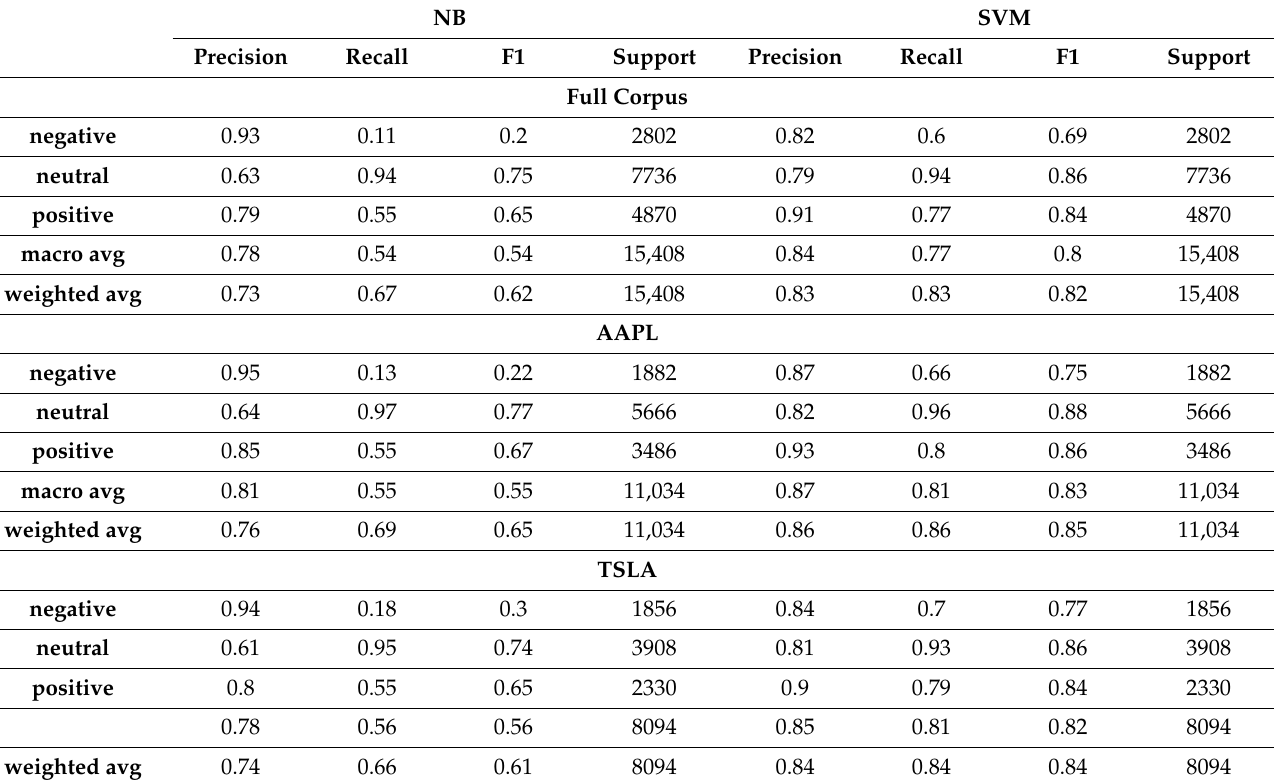
Table 8. Results of Classifiers Supervised Against